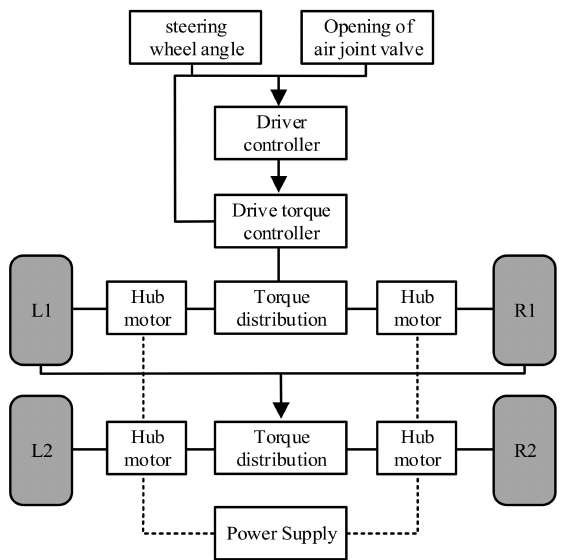
Figure 3. Torque distribution